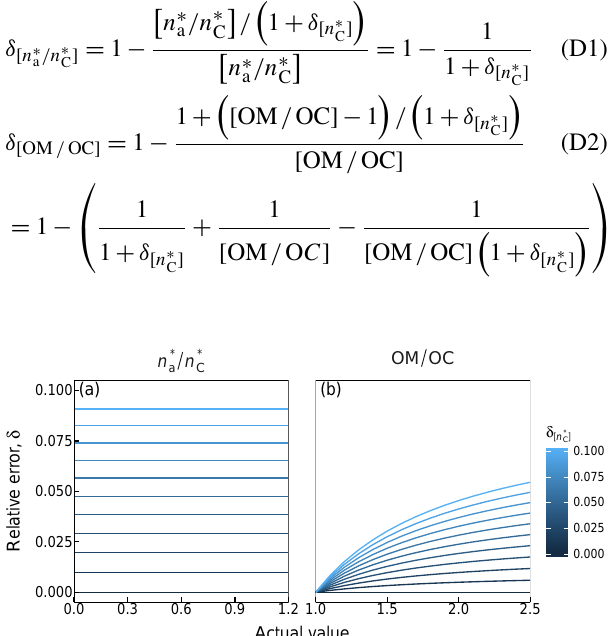
Figure D1. Magnitude of relative errors in atomic ratios ( δ [ n ∗ and OM / OC mass ratios ( δ [ OM / OC ] ) due to relative errors ( δ [ n ∗ ] ) in the estimation of number of carbon atoms n C ored lines shown in each panel correspond to values of δ [ n ∗ { 0 . 0 , 0 . 01 , 0 . 02 ,..., 0 . 1 }